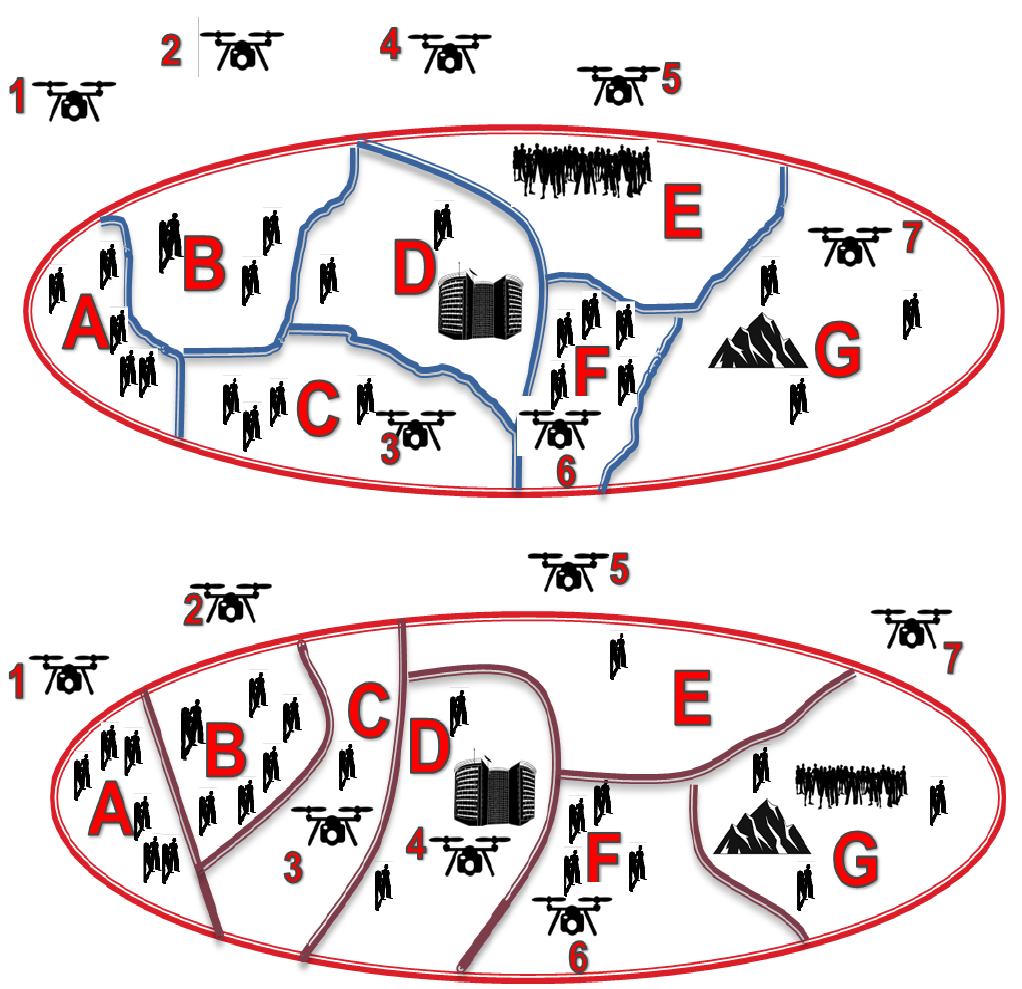
Figure 10. An example of area partition with subareas served by a single UAV ( upper-side plot ); the boundaries of the curves change as a function of the traffic variations, thus implying a modification of the UAV locations accordingly ( lower-side plot